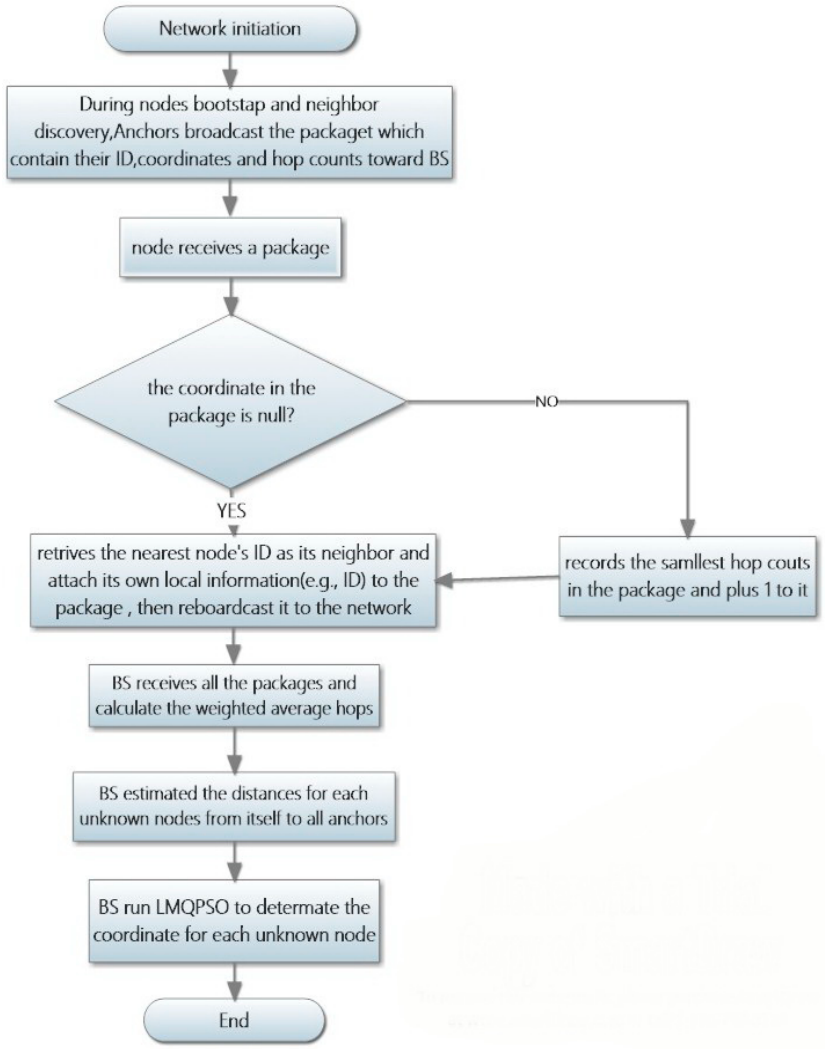
Figure 2. Flowchart of LMQPDV-hop.